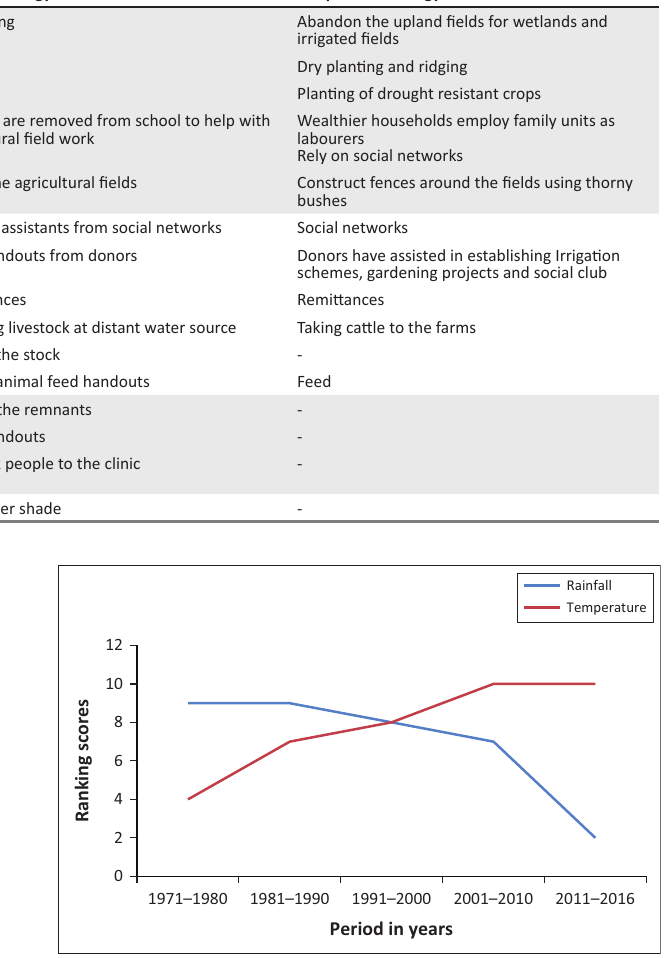
TABLE 1: Community-perceived stressors, impacts and community responses by coping and adapting. Climate phenomenon Impacts